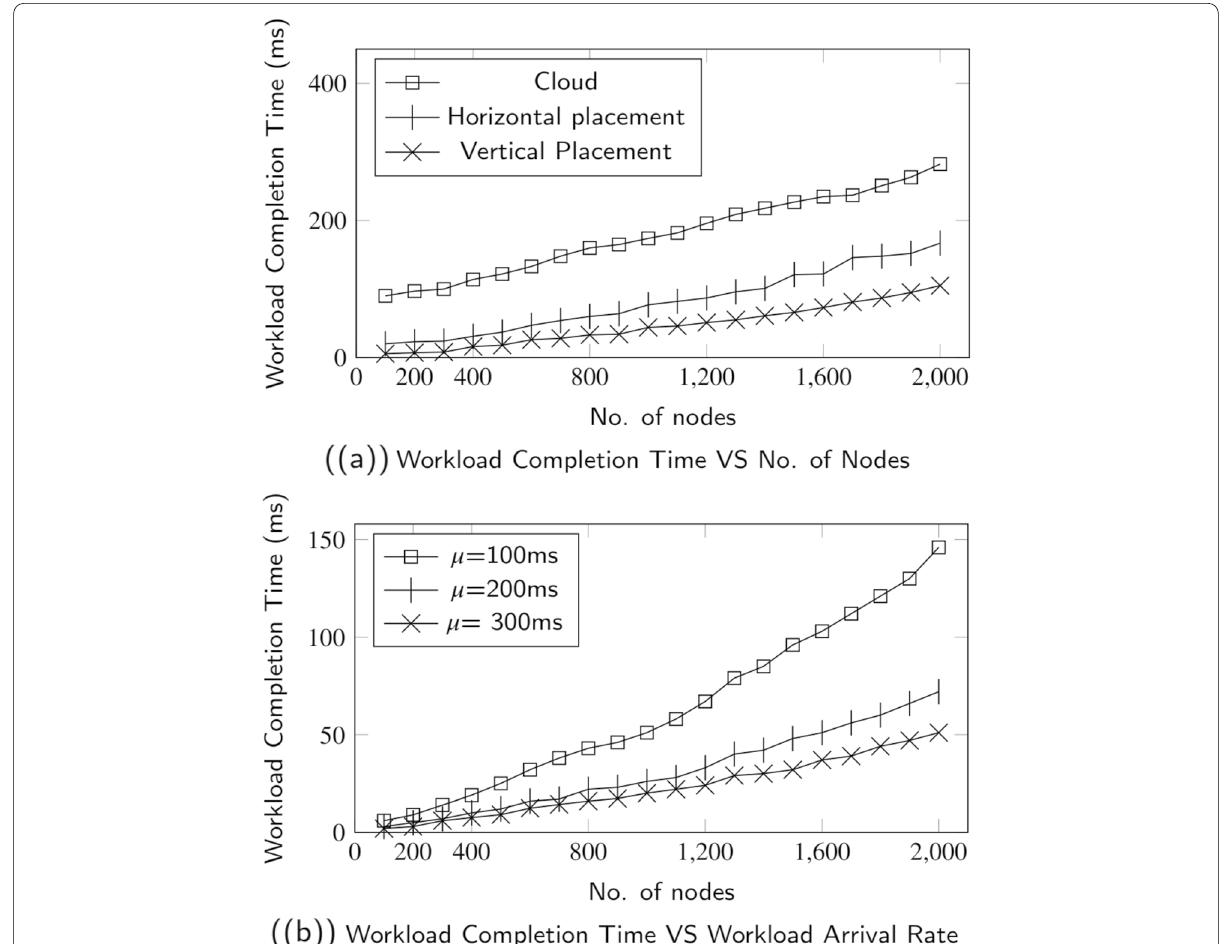
Fig. 5 Workload completion time with different arrival rate and network setup